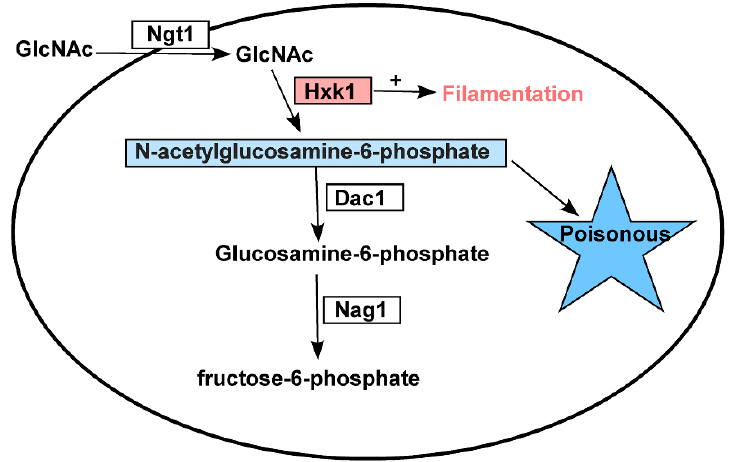
Figure 7. A model of how N- acetylglucosamine metabolism-related genes govern C. tropicalis functionality. HXK1 positively regulates filamentous growth in addition to catalyzing the phosphorylation of GlcNAc, with excess GlcNAc-6-PO 4 being toxic to C. tropicalis .